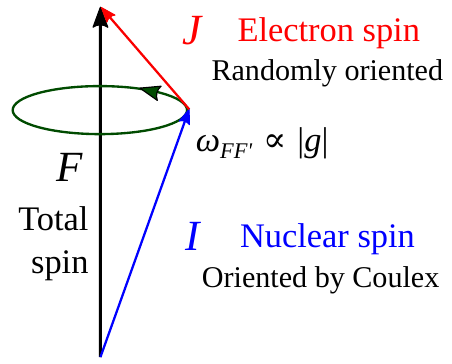
Figure 1. Spin coupling between the nuclear ( I ) and electron ( J ) spins, combining such that F = I + J . The dipole interaction results in a precession about F with angular frequency ω FF (cid:48) [see Eq.